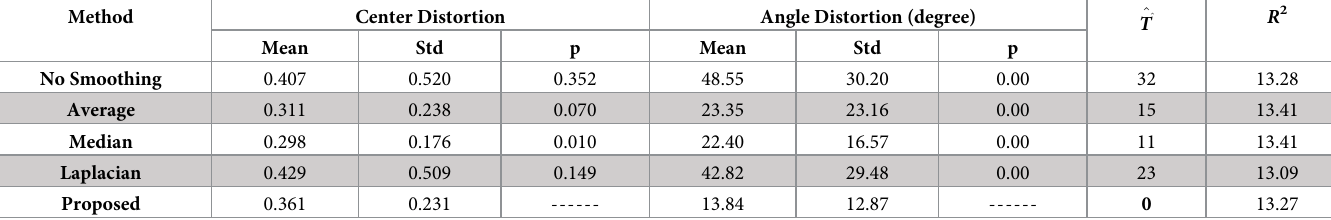
Table 4. Comparison of different smoothing methods based on noisy fMRI decoding with about 22% of flipping triangles.